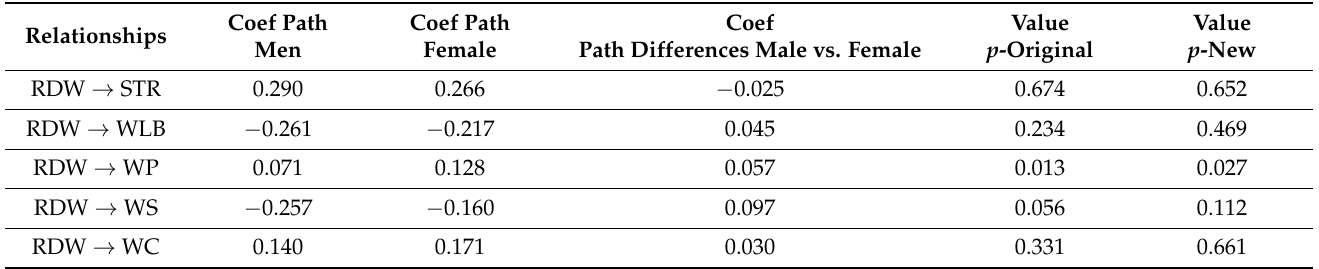
Table 4. PLS-MGA